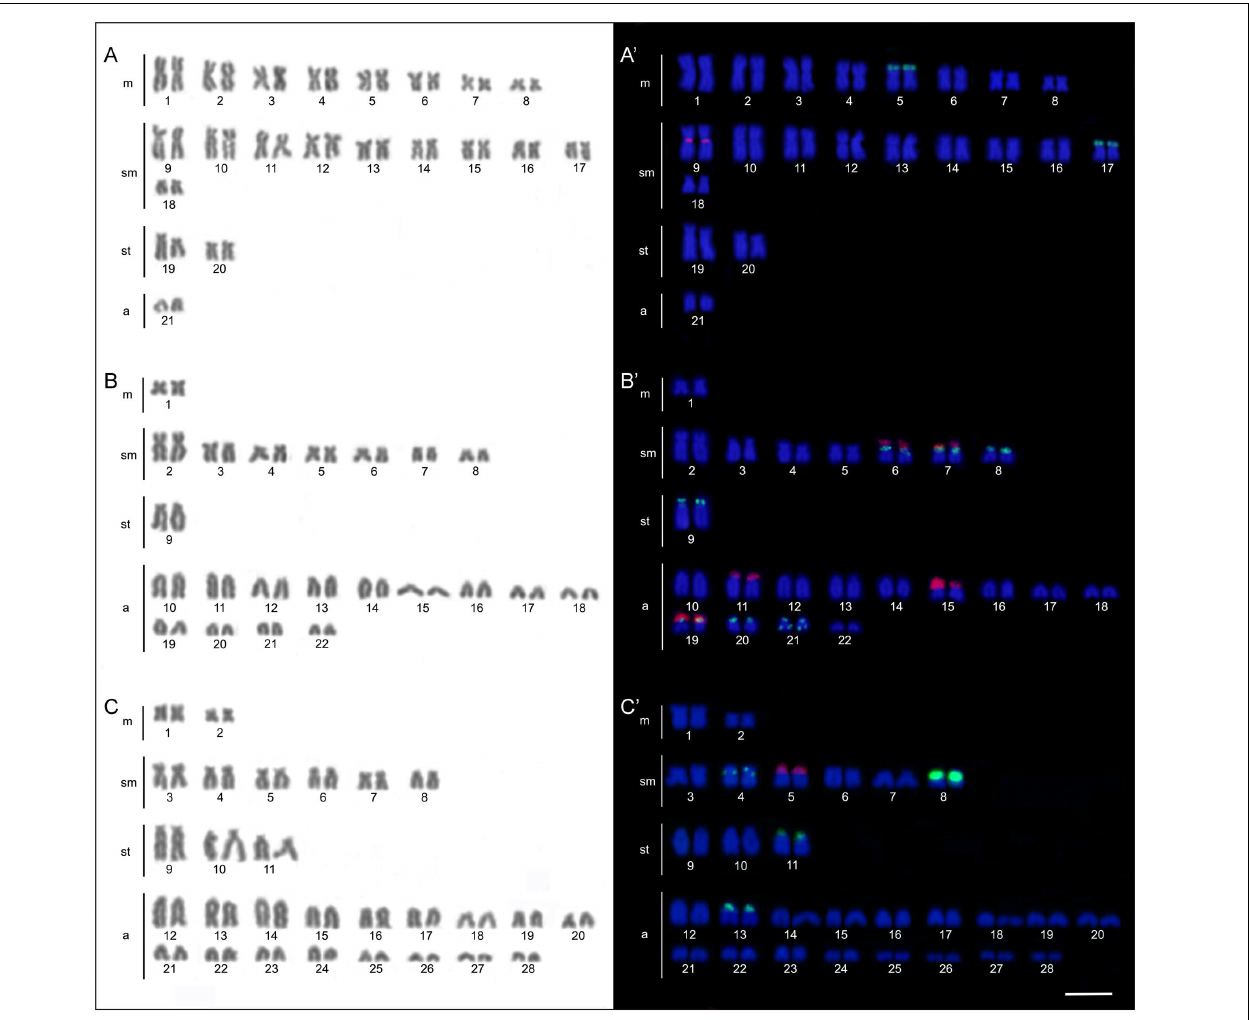
FIGURE 2 | Bunocephalus coracoideus karyotypes. On the left, Giemsa staining; on the right. Double-FISH evidencing chromosome pairs bearing the 18S rDNA (red) and 5S rDNA (green) sequences. (A,A (cid:48) ) ESU-A Igarapé Jundiá – Cuieiras River, (B,B (cid:48) ) ESU –B Demini River (Cuieiras River) and (C,C (cid:48) ) ESU-C Igarapé Apeú – Guamá River. Bar = 10 µ